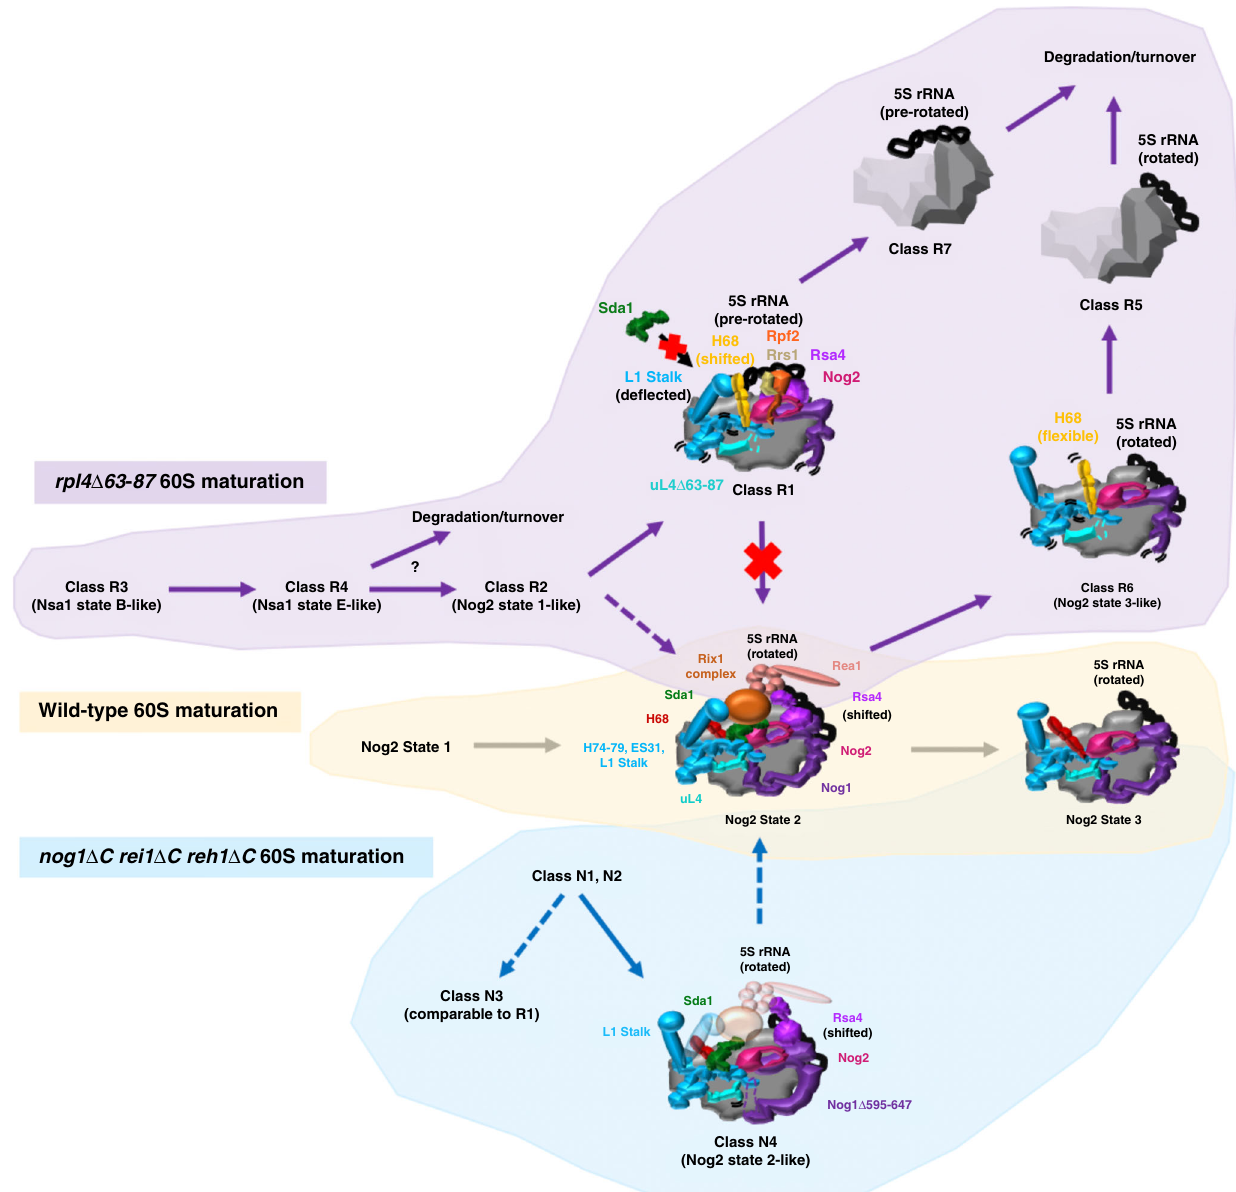
Fig. 8 NPET maturation in the 60S subunit assembly hierarchy. In the wild-type 60S subunit assembly pathway (middle, tan), Nog2 state 1 progresses to Nog2 state 2 particles, which have bound AFs Sda1 (dark green), the Rix1 complex (orange), and Rea1 (coral). The L1 stalk has closed, and the 5S rRNA has rotated ~180°. Rsa4 (light purple) has also shifted to face Rea1. These wild-type particles progress to Nog2 state three particles, which have released multiple AFs and are ready to exchange Nog2 for Nmd3 and be exported from the nucleoplasm to the cytoplasm. In the rpl4 Δ 63 – 87 mutant (top, purple) classes R3 and R4 are the earliest chronological particles to be observed. Some fraction presumably progresses to class R2. Class R2 particles are wild- type-like and likely progress to class R1 particles, which display a shifted rRNA helix H68 (gold) that prevents binding of Sda1 and progression to Nog2 state 2. These class R2 particles are likely precursors to class R7 on a pathway to turnover. Alternatively, some fraction of class R2 particles may progress past Nog2 state 2 to class R6, which displays aberrant conformations of multiple rRNA helices. Consequently, class R6 particles are likely precursors to class R5 on a pathway to turnover. In the nog1 Δ C rei1 Δ C reh1 Δ C mutant, wild-type-like classes N1 and N2 (bottom, teal) progress to either N3, which resembles class R1, or class N4. Class N4 primarily displays density for the L1 stalk in an open position and Sda1 is bound, but weak densities (transparent colors) can be seen for the Rix1 complex, Rea1, and the L1 stalk in a closed position. Some fraction of class N4 particles likely progresses to Nog2 state 3. Two curved black lines represent fl exibility in protein or rRNA structure. Solid vs. dotted arrows represent major and minor pathways,